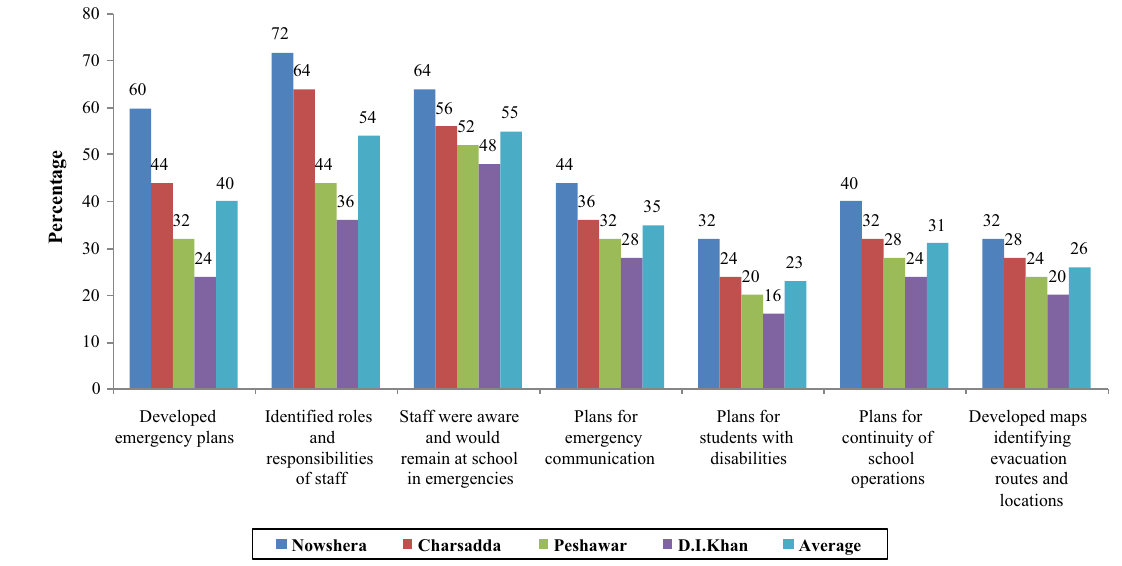
Fig. 3 Emergency planning and preparedness activities of Khyber Pakhtunkhwa’s schools, 2010–2017